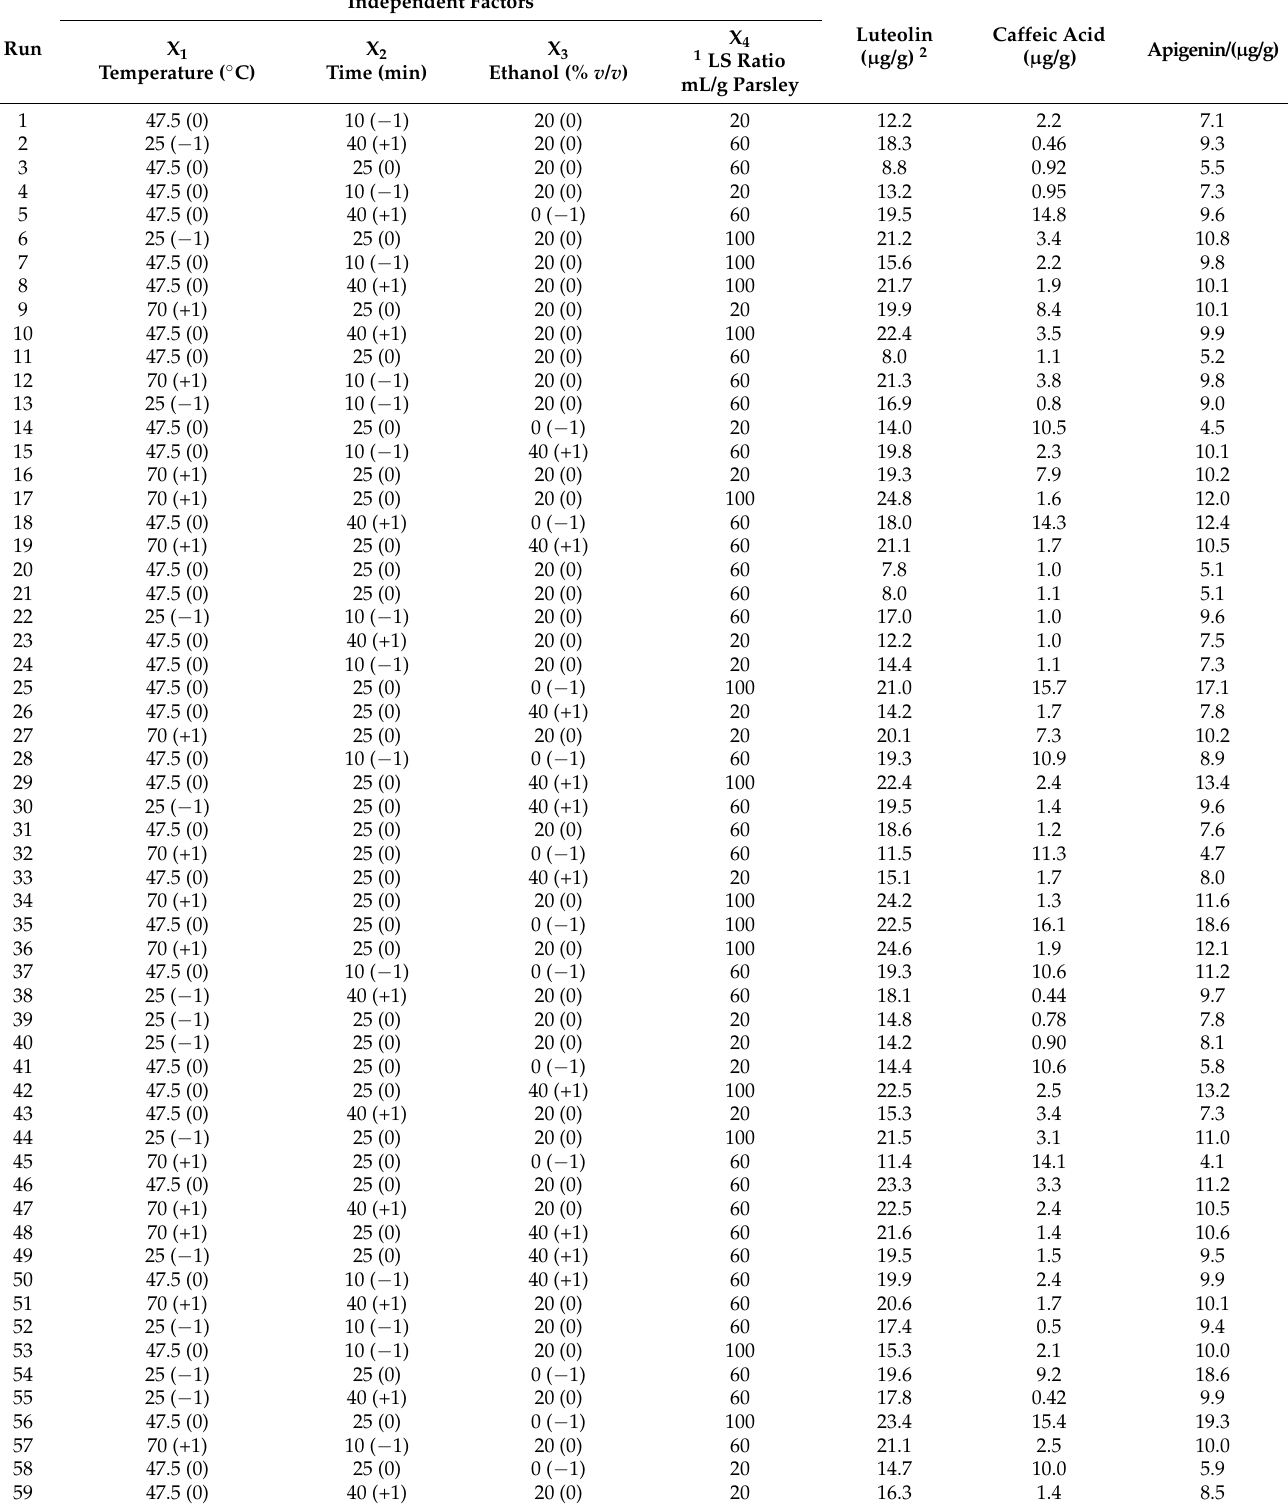
Table 2. Coded and actual values of BBD design, along with the experimental results of of quantifica- tion for luteolin, caffeic acid, and apigenin from